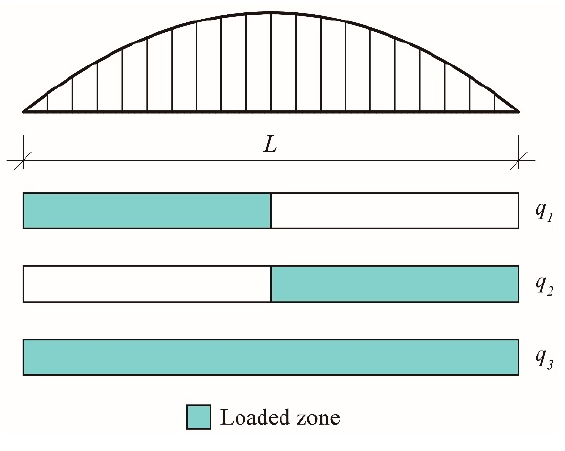
Figure 4. Load cases considered (see IAP [14] and EC-1 [15]).